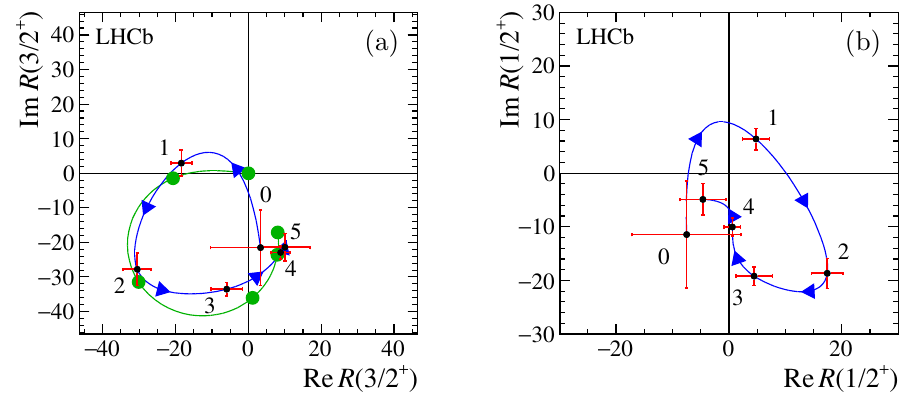
Figure 11 . Argand diagrams for the complex spline components used in two (cid:12)ts, represented by blue lines with arrows indicating the phase motion with increasing M ( D 0 p ). For sub(cid:12)gure (a), the J P = 3 = 2 + partial wave is modelled as a spline and the other components in the (cid:12)t (1 = 2 + , 1 = 2 (cid:0) and 3 = 2 (cid:0) ) are described with exponential amplitudes. For comparison, results from a separate (cid:12)t in which the 3 = 2 + partial wave is described with a Breit-Wigner function are superimposed: the green line represents its phase motion, and the green dots correspond to the D 0 p masses at the spline knots. For sub(cid:12)gure (b), the J P = 1 = 2 + component is modelled as a spline and 1 = 2 (cid:0) , 3 = 2 + and 3 = 2 (cid:0) components as exponential amplitudes.